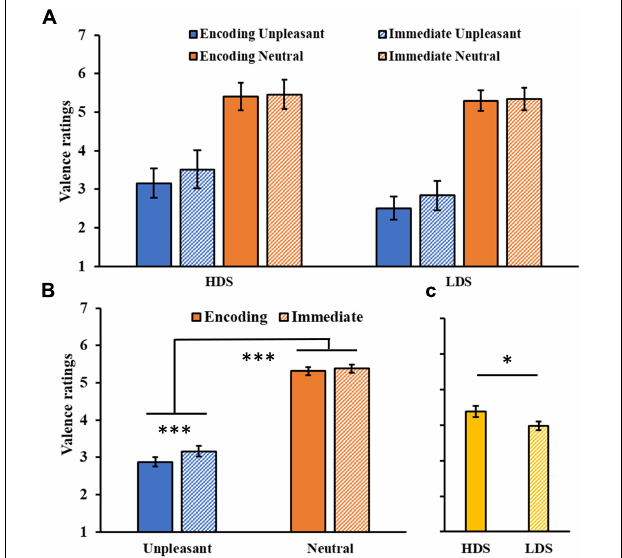
FIGURE 2 | (A) Valence ratings as a function of the group and of the category of stimuli (unpleasant and neutral pictures) at the encoding and at the immediate recognition sessions. (B) Session (encoding and immediate recognition sessions) × Category (unpleasant and neutral pictures) interaction for the valence ratings. (C) Group (HDS and LDS) main effect for valence ratings. LDS: participants with lower depression symptoms; HDS: participants with higher depression symptoms. Error bars represent standard error of the mean. ∗ p < 0.05; ∗∗∗ p <